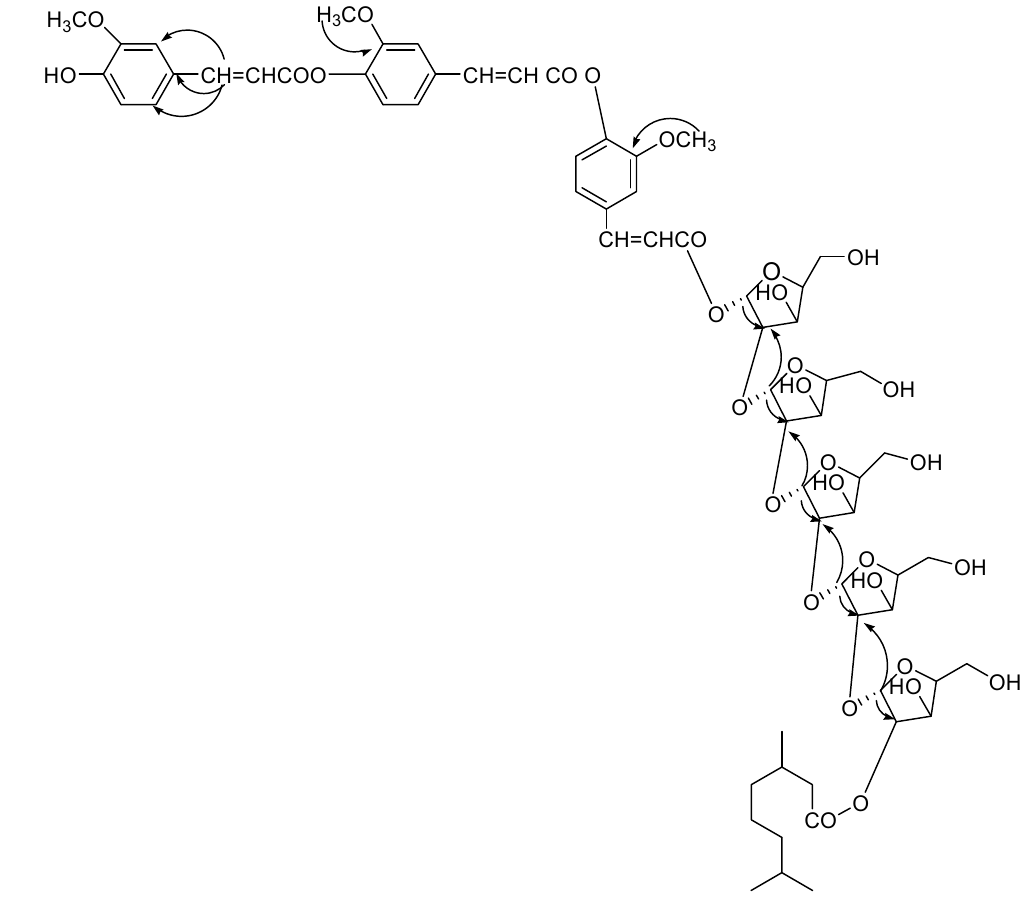
Figure 7. HMBC correlation of compound 4 .